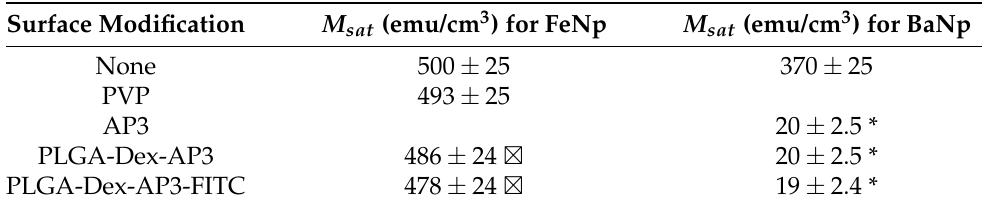
Table 5. Modification/milling effects on saturation magnetization of different MNP types. Each successive surface modification decreases the MNPs saturation magnetization by 1.45%, while milling decreases it by 95%, i.e., DL-2-amino-3-phosphonopropionic acid (AP3) BaNp. Saturation magnetization M sat and its uncertainty was estimated from magnetometry measurements given in Ref. [17] and propagated from errors by the method of Section 2.8 for each surface modification. Surface Modification